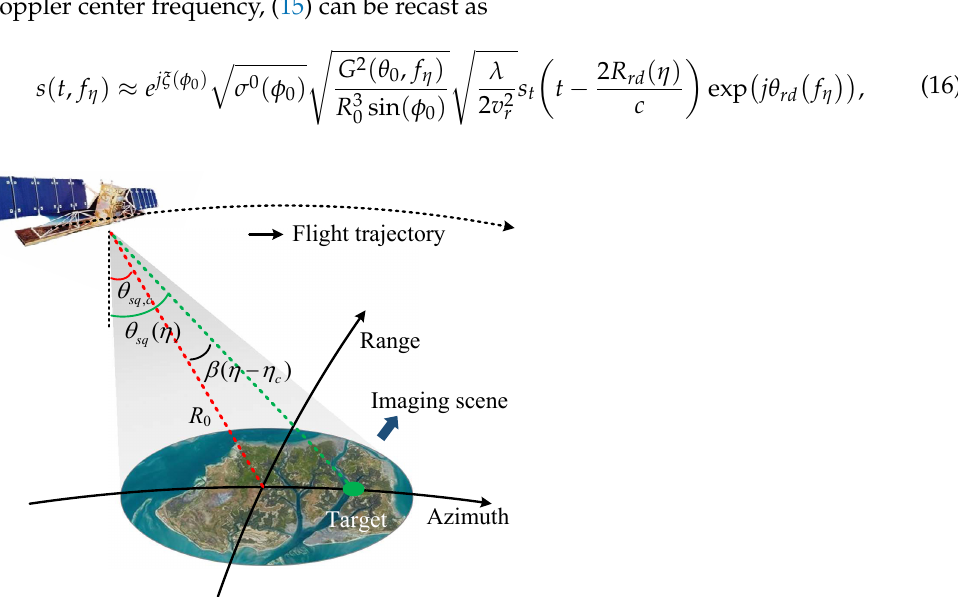
Figure 1. The illustration for β ( η − η c ) , where the red dotted line is the beam center line, and the green dotted line is the look line between the target and the